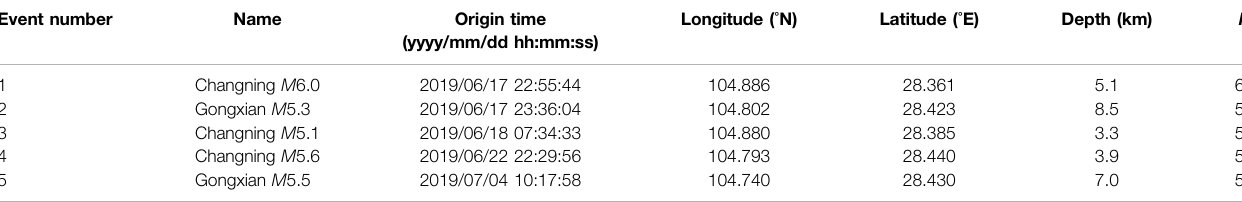
TABLE 1 | Earthquake catalogs for fi ve M 5.0 + events occurring during the 2019 – 2020 Changning seismic sequence. Event